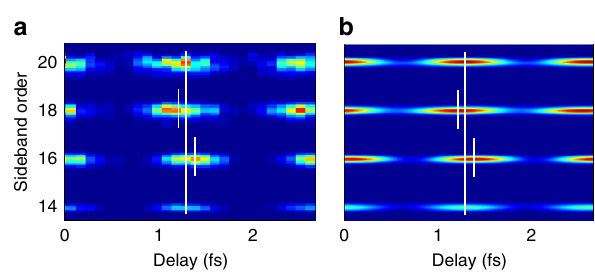
Figure 2 | Photoelectron spectra as a function of delay. ( a ) Photoelectron